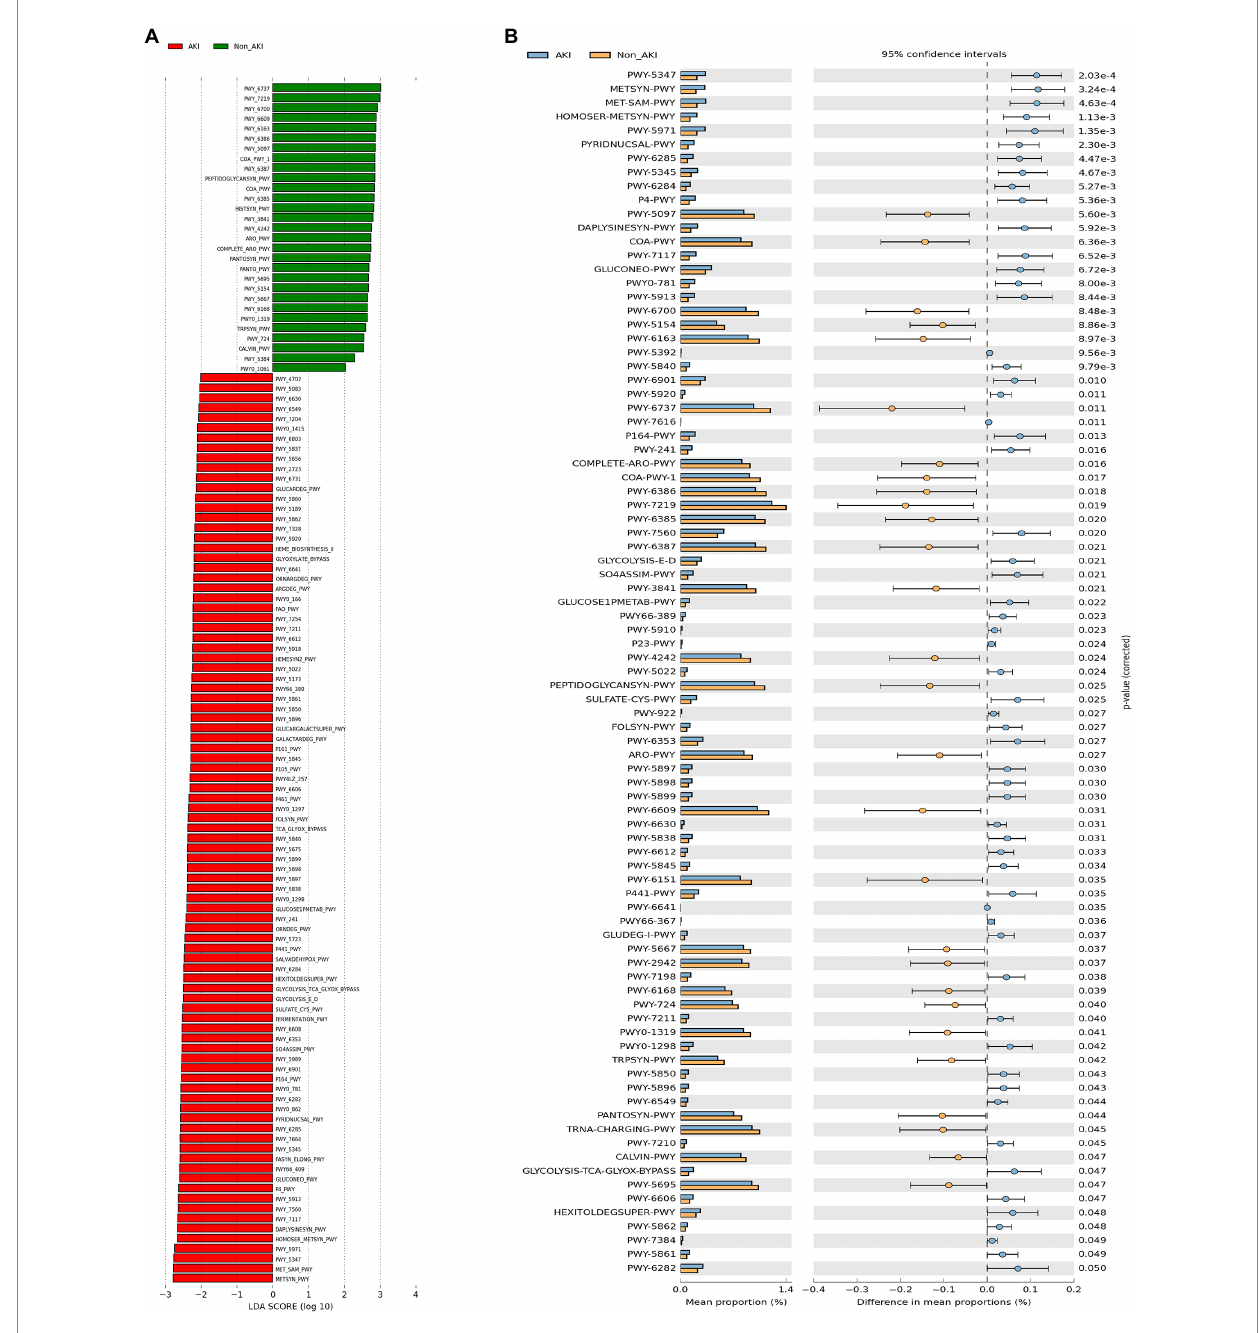
FIGURE 5 Pathway differences between the AKI and Non_AKI groups. (A) LEfSe analysis (LDA > 2); (B) STAMP